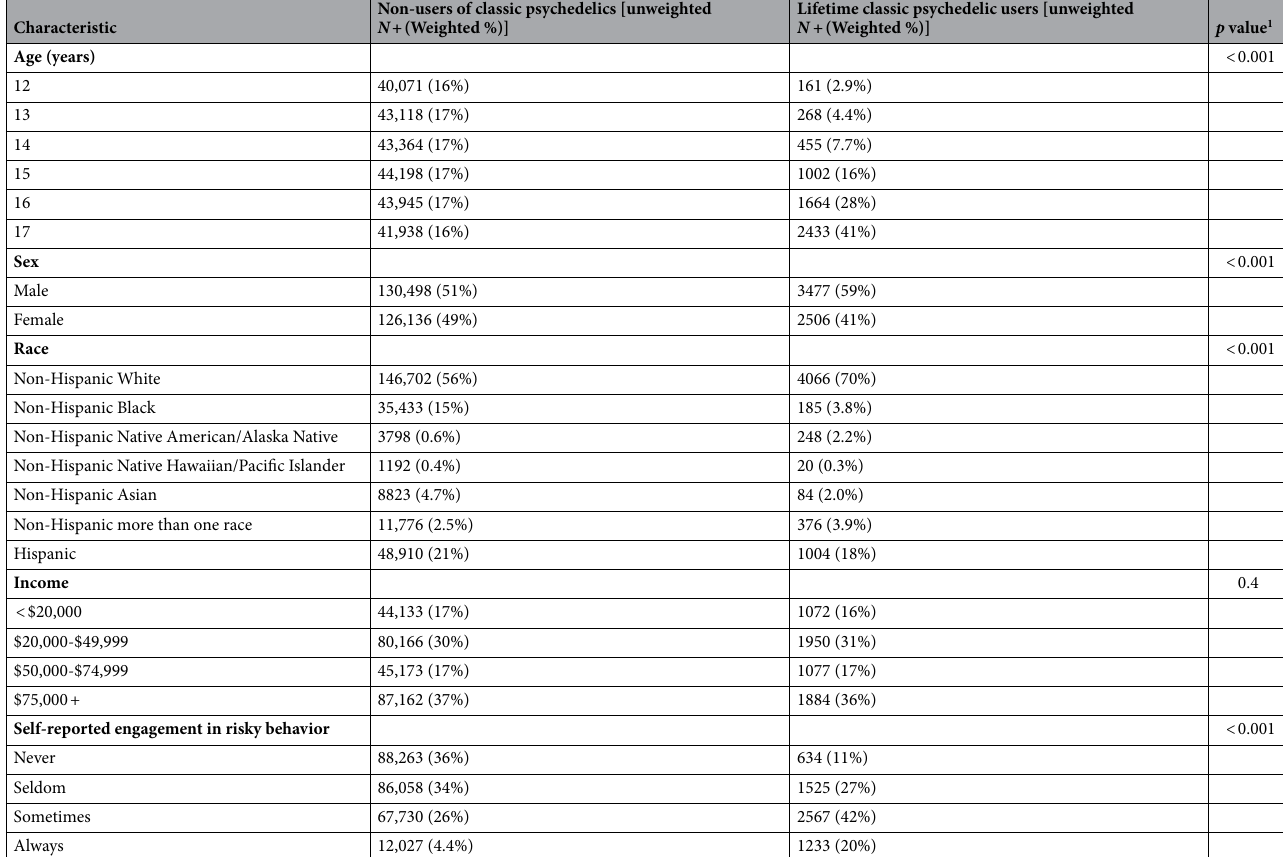
Table 1. Demographic of those who have versus have not used classic psychedelics. 1 Chi-squared test with Rao & Scott’s second-order